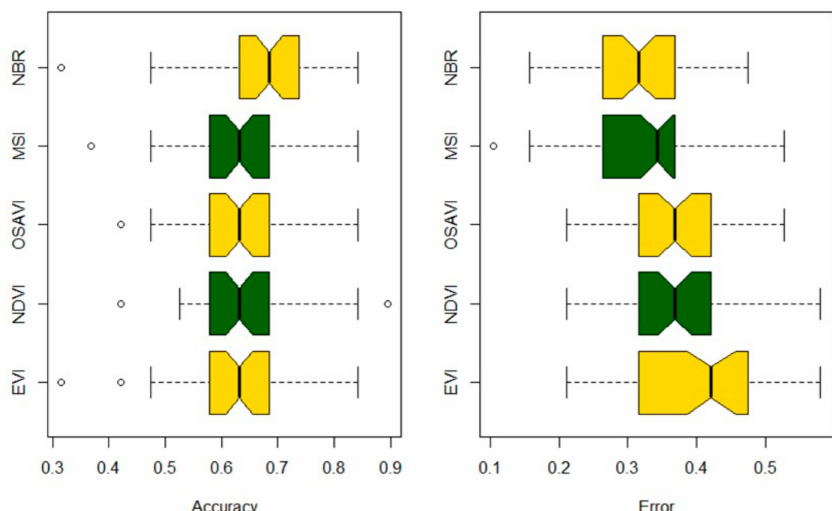
Figure 3. Global error and overall accuracy values of The Normalized Burn Ratio (NBR); Moisture Stress Index (MSI); Optimized Soil Adjusted Vegetation Index (OSAVI); Normalized Di ff erence Vegetation Index (NDVI); and Enhanced Vegetation Index (EVI) for classification defoliation grades of Pinus pinaster forests obtained through hold-out cross-validation (NN: Neural